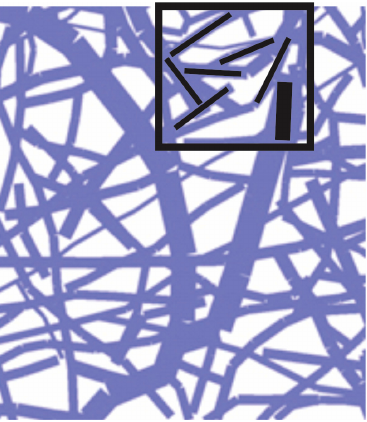
Figure 4. Network of fibers and a domain of finite element with indicated fiber directions (domain is 90 µm × 90 µm).